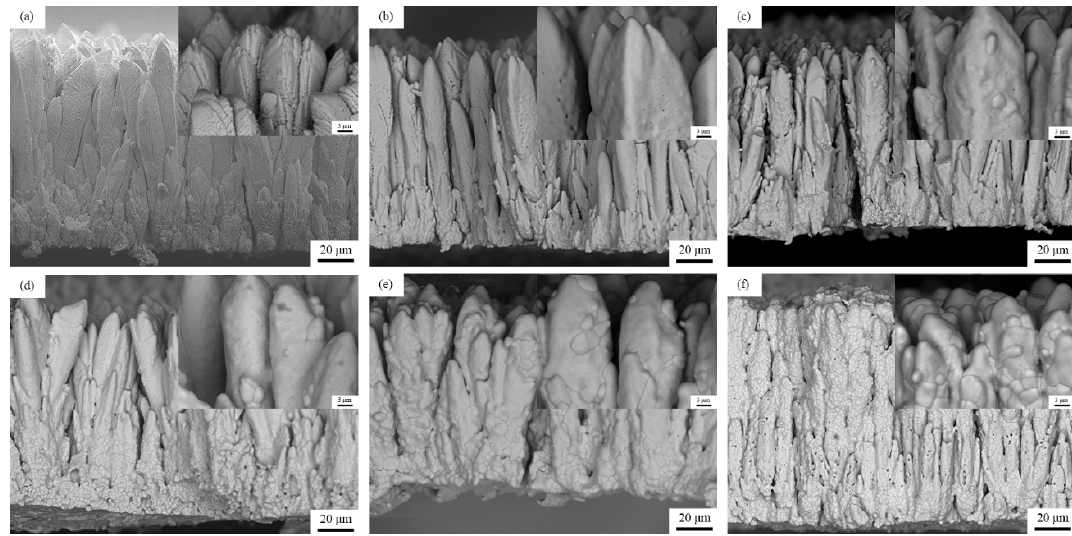
Figure 3. SEM images of fracture section of YSZ-2 coatings before and after thermal aging treatment in air at 1550 °C as a function of time: ( a ) as-sprayed; ( b ) 20 h; ( c ) 40 h; ( d ) 60 h; ( e ) 80 h; ( f ) 100 h.